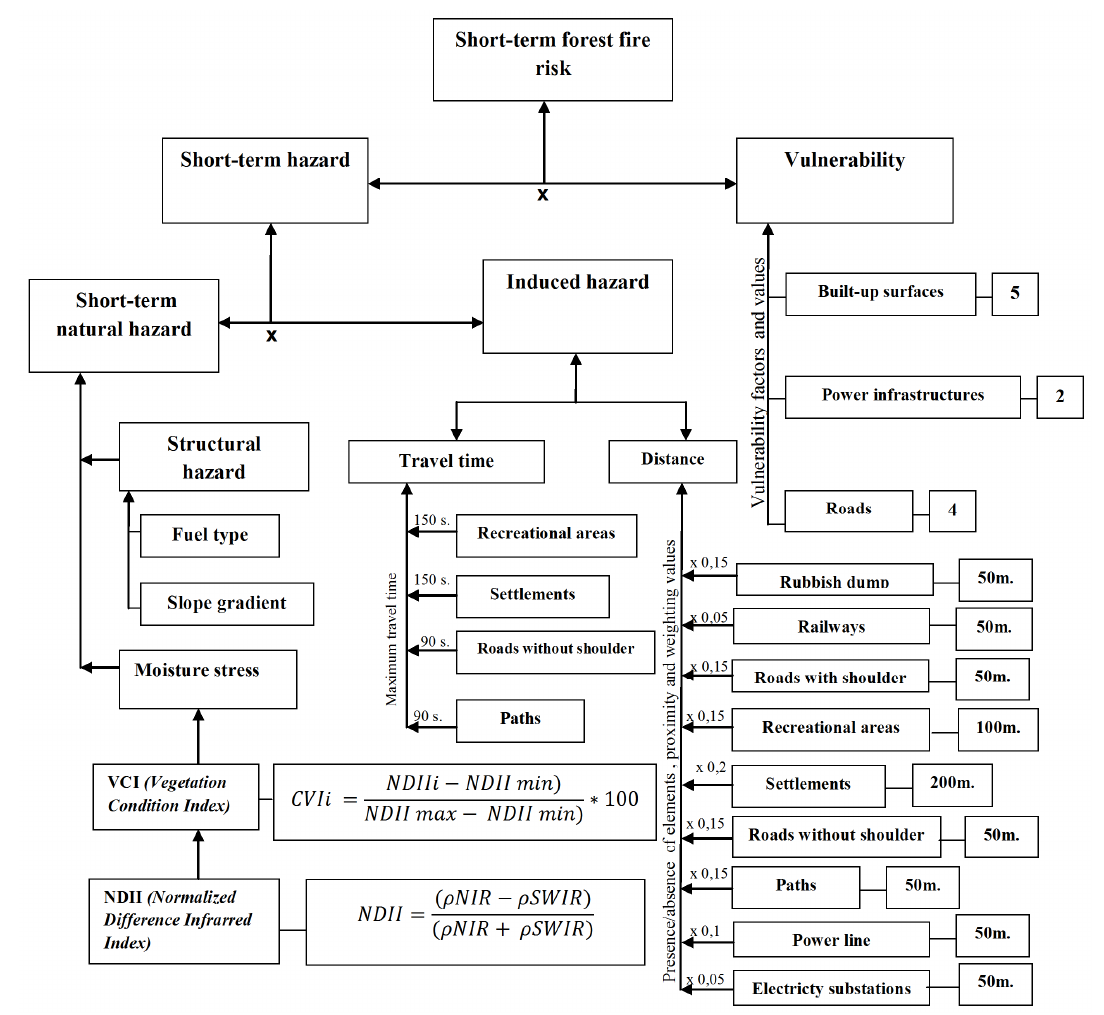
Figure 3. Methodology diagram.